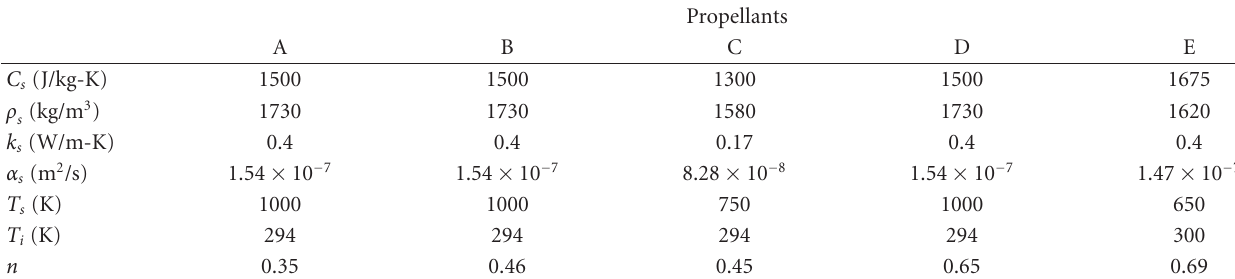
Table 1: Propellant characteristics.